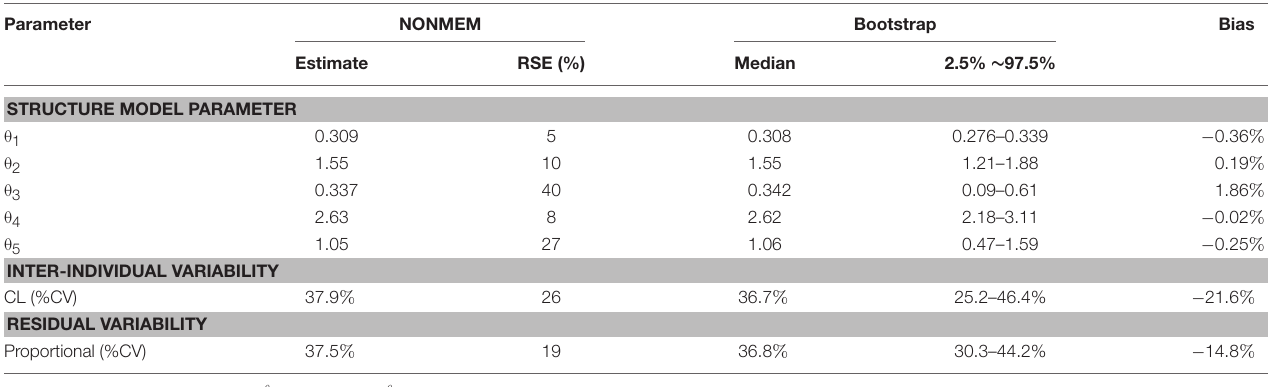
TABLE 3 | Population pharmacokinetic estimates of vancomycin of final model and Bootstrap